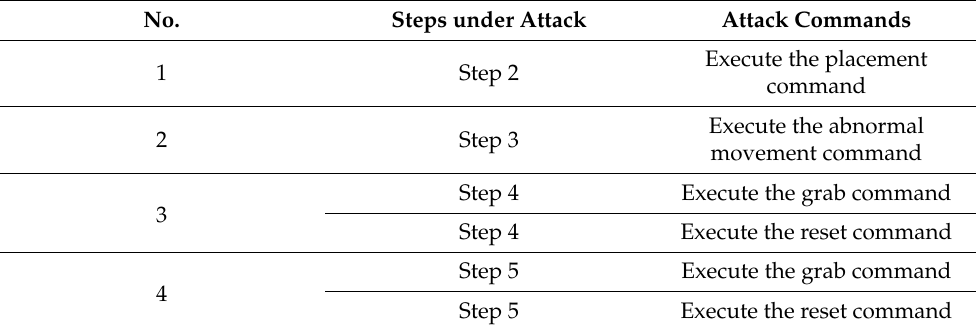
Table 3. Attack behavior of the